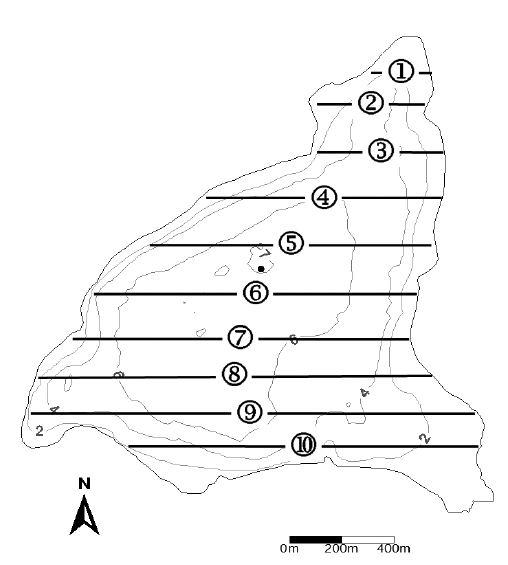
Figure 2. Bathymetric chart of central Lake (Lagoa Santa, MG, Brazil) showing the ten transects followed during the acoustic